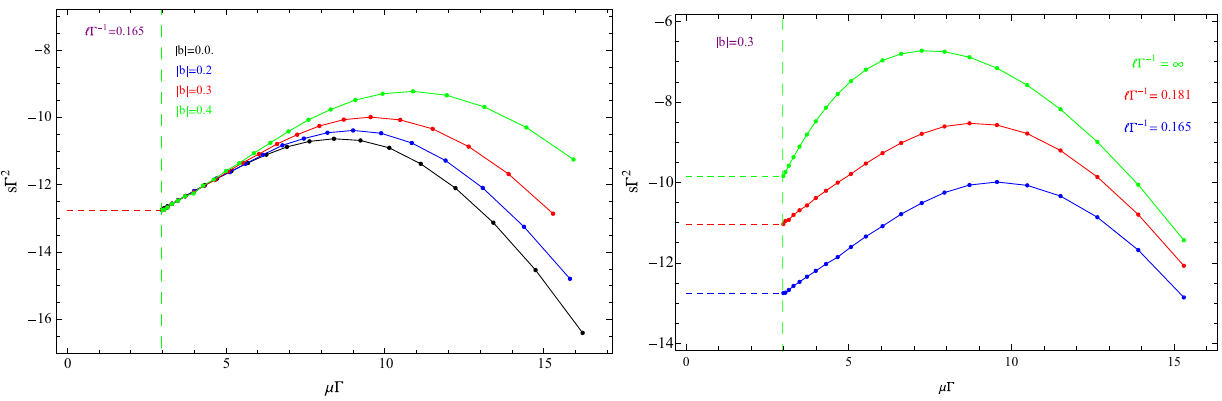
Fig. 5 Theentanglemententropy s asafunctionofthechemicalpoten- tial μ for the various factors,i.e., the ENE factor b and the belt width (cid:16) . The horizontal dotted lines denote the entropy in the insulator phase, the green vertical dashed line denotes the critical phase transition point where μ c (cid:10) = 2 . 9662, and the solid curves denote the entropy in the